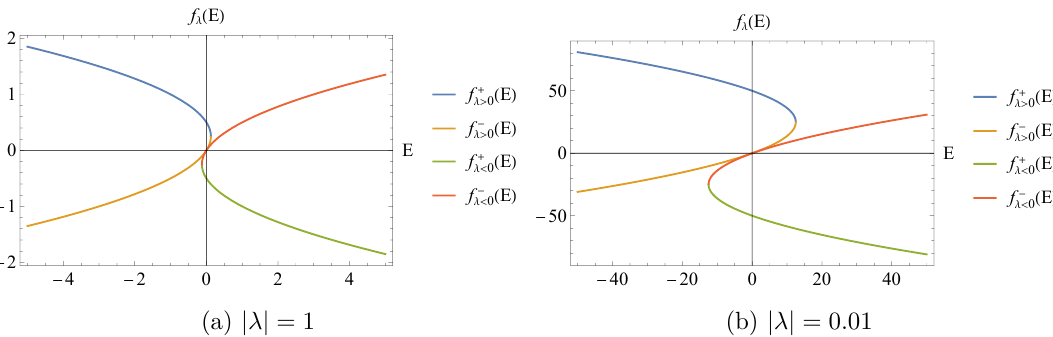
Figure 1. We plot the entire deformed energy spectrum as a function of the undeformed energy E when | λ | = 1 and | λ | = 0 . 01 . Here f + ( E ) (blue curve) and f + ( E ) (green curve) together describe λ> 0 λ< 0 the nonperturbative branch. While f − ( E ) (orange curve) and f − ( E ) (red curve) describe the λ> 0 λ< 0 perturbative branch. For either λ > 0 or λ < 0 , we find a smoothly connected curve. We also see that when | λ | decreases, the non-perturbative branch becomes further away from the